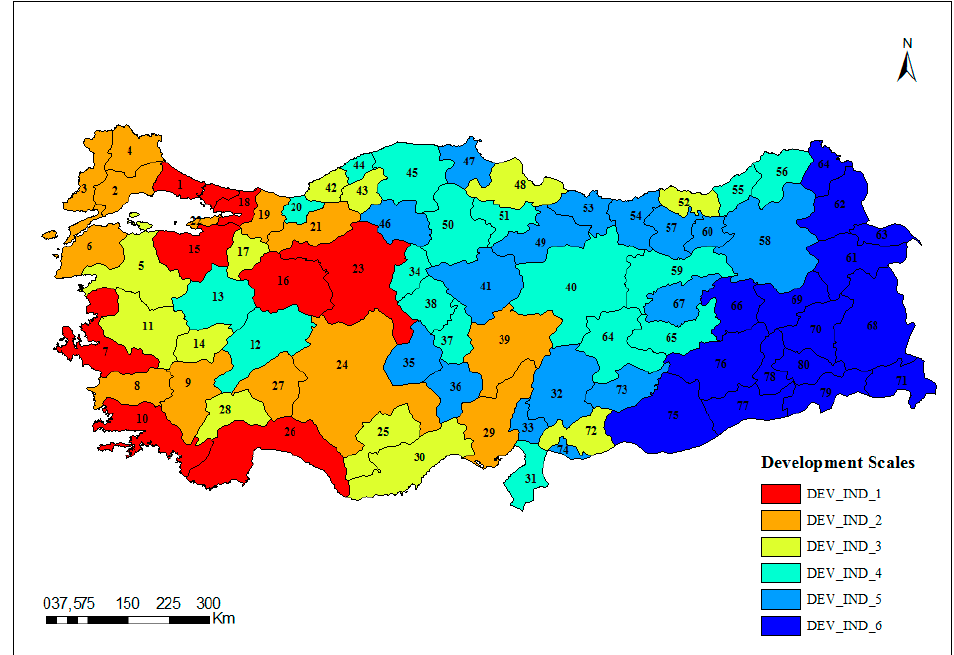
Figure A1. Regional development disparities in Turkey. Note: The map displays six separate groups that were identified according to their level of regional development. DEV_IND_1 represents the regions that are in the first place in terms of socio-economic development while DEV_IND_6 indicates the regions in the last place. Selected NUTS 3 Provinces: 1-Istanbul, 2-Tekirdag, 5-Balıkesir, 6-Çanakkale, 7-Izmir, 9-Denizli, 10-Mu˘gla, 15-Bursa, 16-Eski¸sehir, 18-Kocaeli, 23-Ankara, 24-Konya, 26-Antalya, 29-Adana, 30-Mersin, 39-Kayseri, 48-Samsun, 52-Trabzon, 61-Kars, 63-Van, 64-Malatya, 72-Gaziantep, 76-Diyarbakır. Source: KB [78].